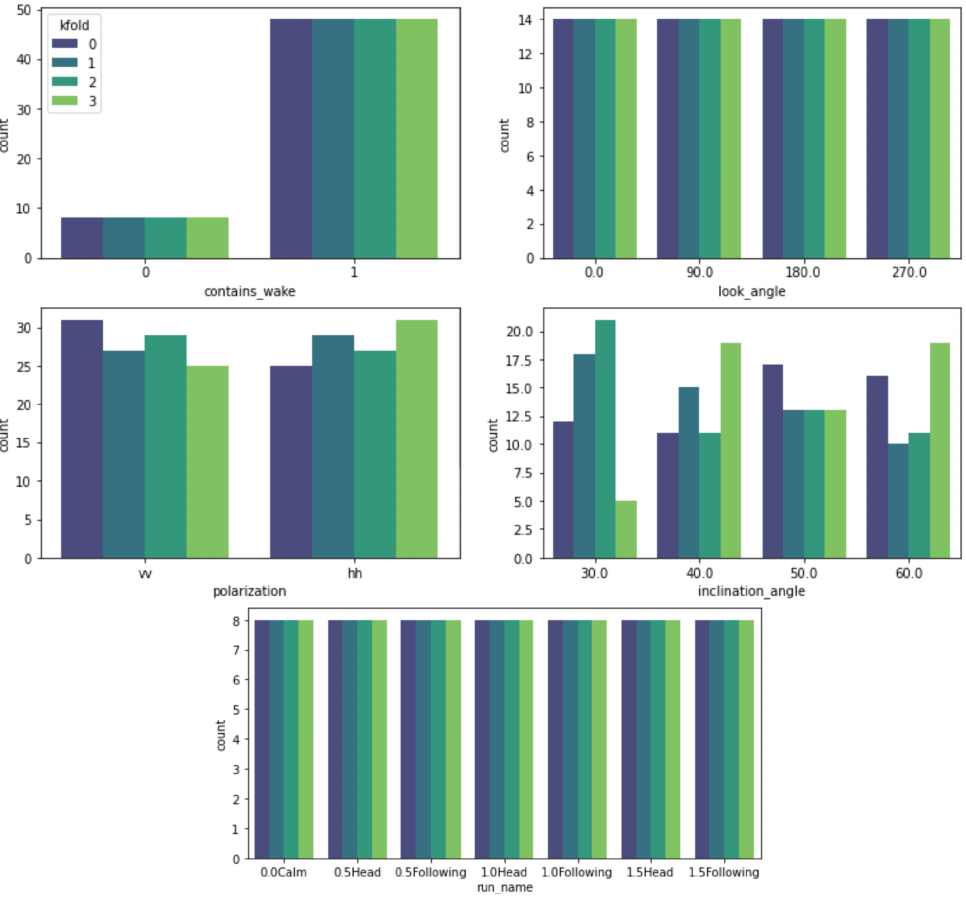
Figure 10. Distribution of the metadata features for the four training and testing folds used in the baseline study. The folds are designed to stratify contains_wake , look_angle , and run_name to have matching distributions for each